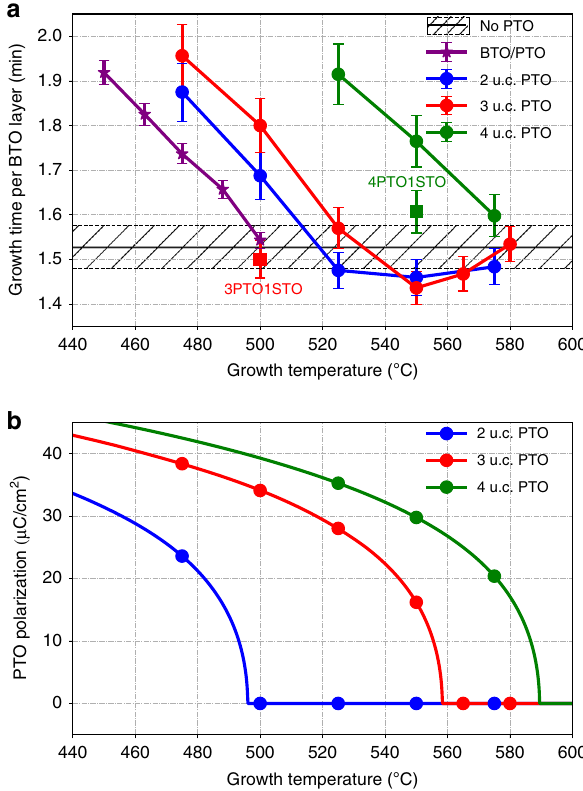
Fig. 1 Growth rates of BTO and polarization of PTO changes vs temperature. Growth rates and polarization associated with phase transition: a Growth time per BTO layer plotted against growth temperatures in 20-nm pure BTO fi lms (black), 50 nm BTO/PTO superlattices (purple), 20 nm BTO fi lms grown on ultrathin PTO fi lms (circle data point markers, blue: 2 u.c. layers PTO, red: 3 u.c. layers PTO, green: 4 u.c. layers PTO), and BTO fi lms with an additional 1 u.c. layer STO on top of PTO ultrathin fi lms (square data point markers, red: 3 u.c. layers PTO, green: 4 u.c. layers PTO). Error bars re fl ect uncertainty in the thickness of the fi lms as obtained by x-ray diffraction measurements and fi tting b Polarization of ultrathin PTO fi lms under growth conditions calculated according to Eq. (1). Source data are provided as a Source Data fi